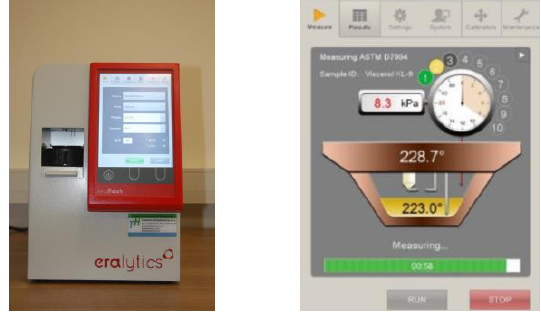
Fig. 6. Apparatus for testing the flash point in a closed cup – EraFLASH [41, 42]